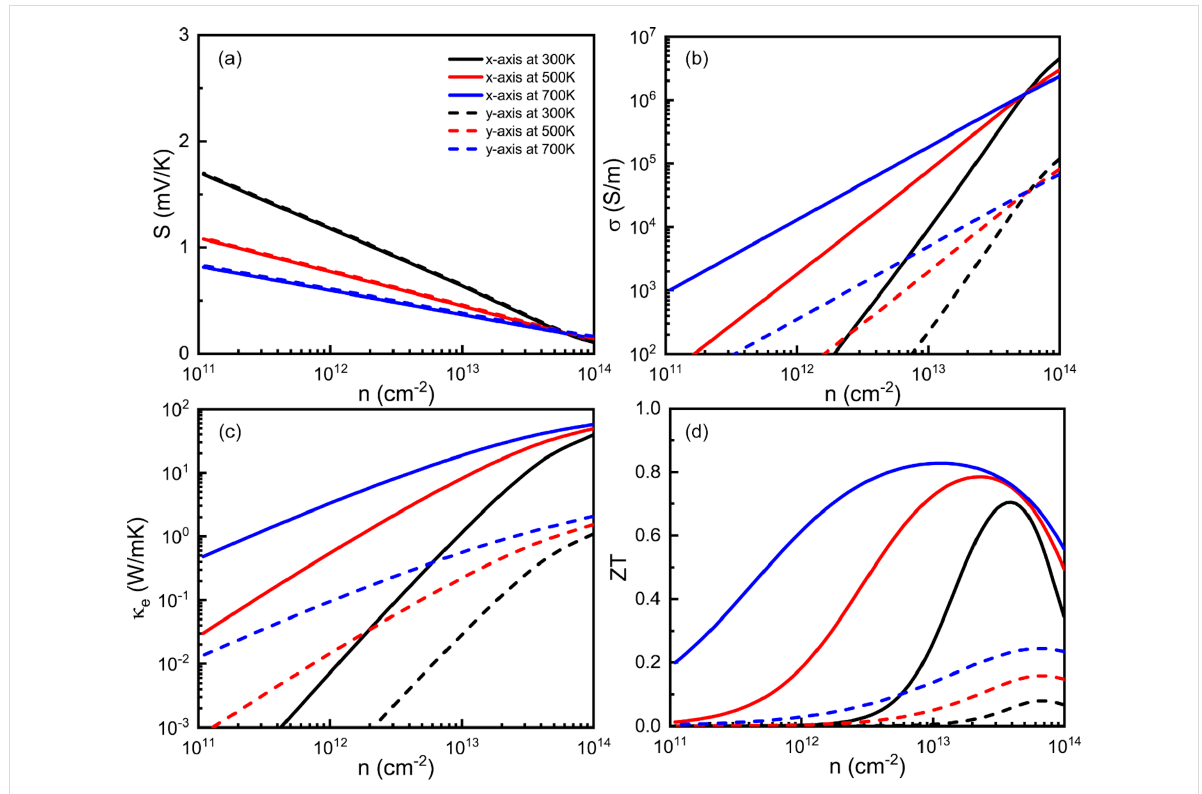
Figure 2: Transport and thermoelectric properties of the MoO 3 monolayer. (a) Seebeck coefficient, S , (b) electrical conductivity, σ , (c) electrical conductivity, κ e , and (d) ZT values as a function of the carrier concentration.